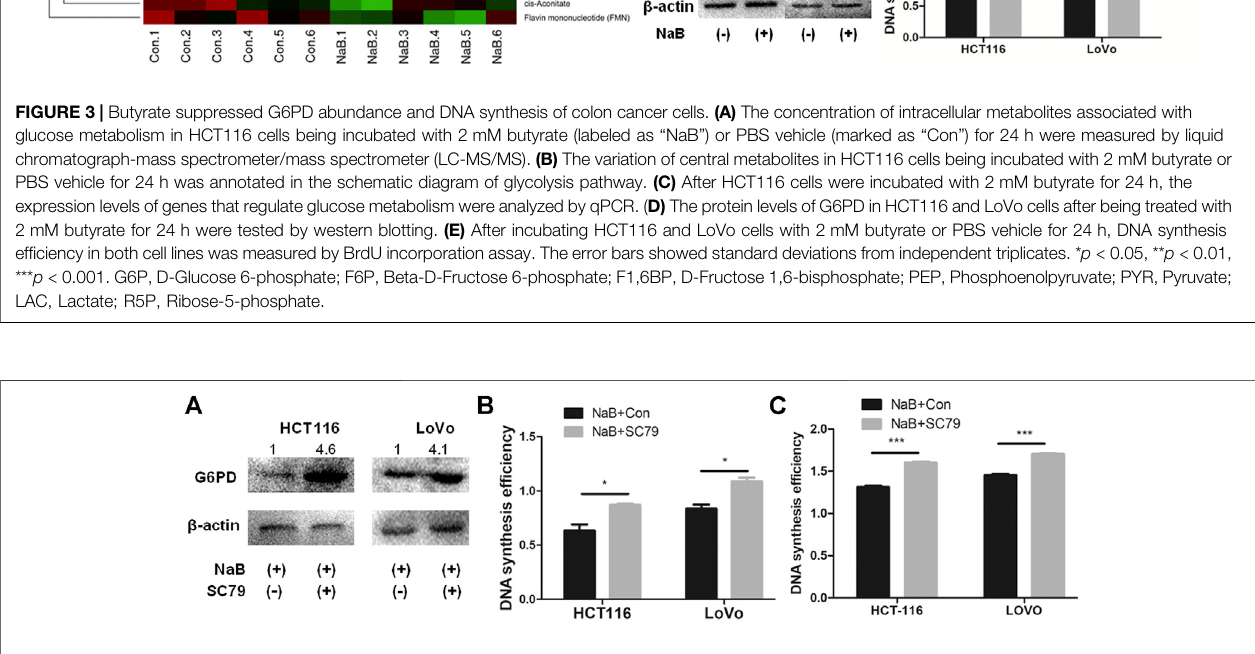
Frontiers in Molecular Biosciences |